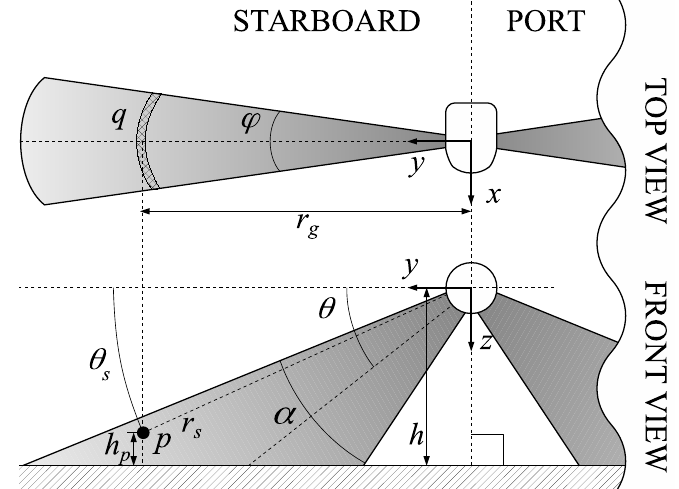
Figure 1. Side-scan sonar model. The x axis points to the AUV motion direction or along-track